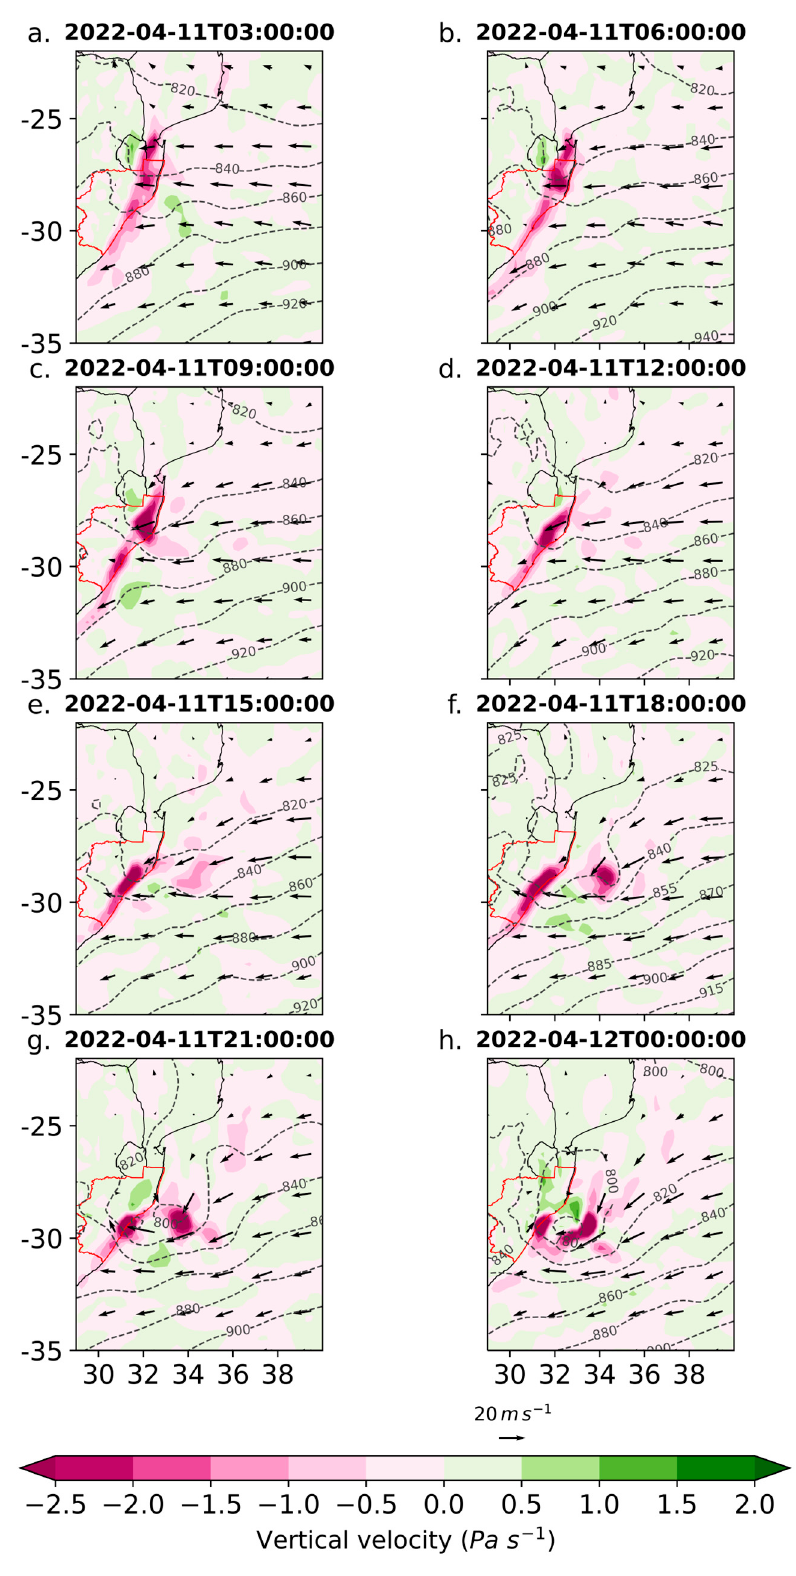
Figure 7. Same as Figure 6, but for vertical velocity (shaded; Pa s − 1 ) and wind speed (vectors; m.s − 1 ) at the 925 hPa pressure level.